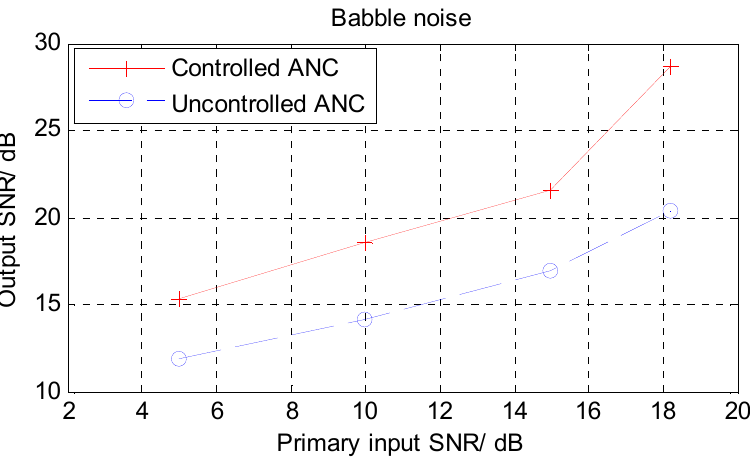
Figure 12. Comparison of SNR performance between threshold controlled and uncontrolled ANCs with noise babble as background